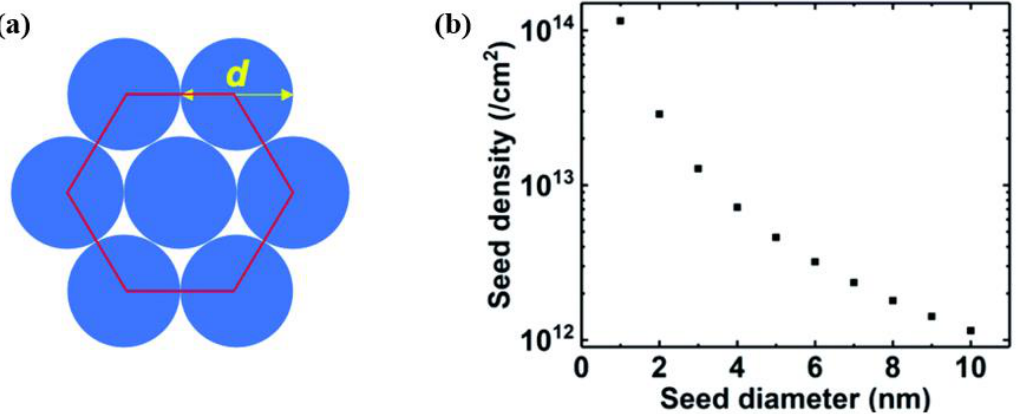
Figure 4. ( a ) Arrangement model of spherical seeds in hexagonal close packed structure. ( b ) Maxi- mum possible seed density based on corresponding model [56].